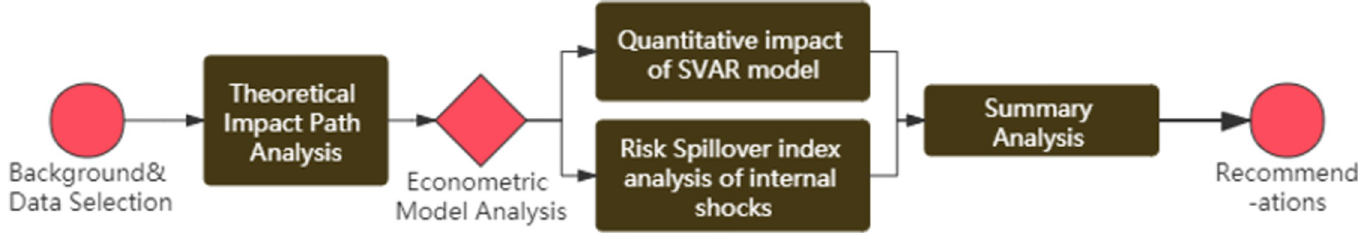
Fig 1. Structure diagram of the article’s